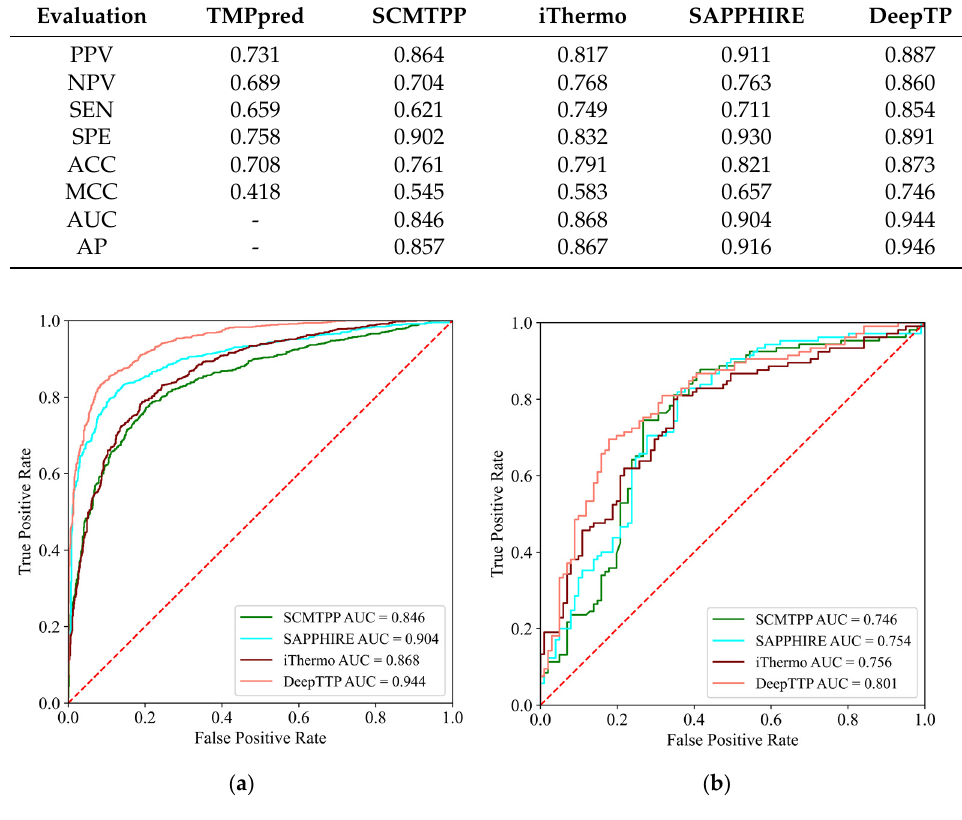
Figure 1. ROC curves on tools in ( a ) independent balanced test set. ( b ) validation set.